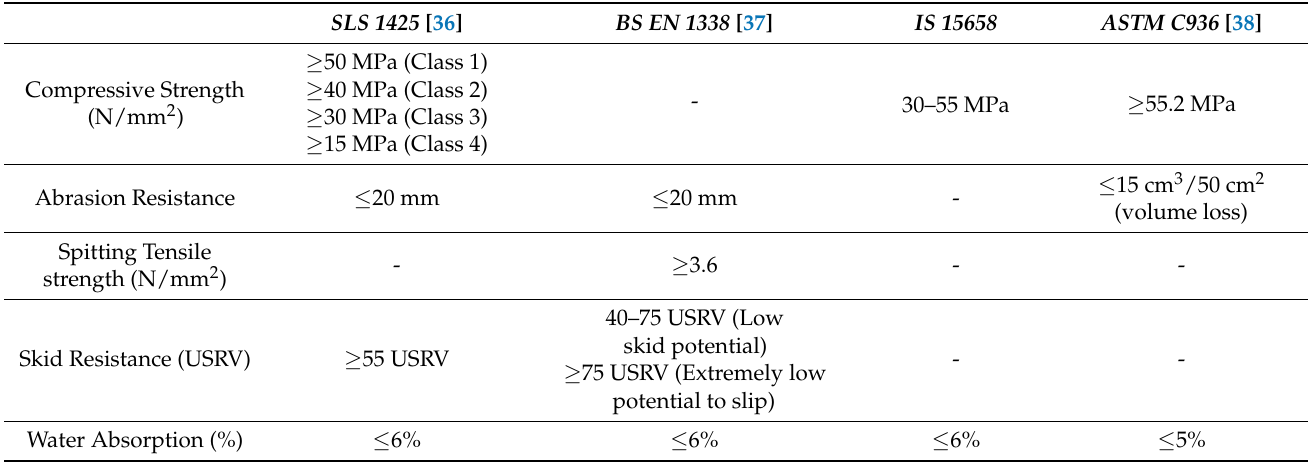
Table 2. Standards specified in code of practice for IPBs.